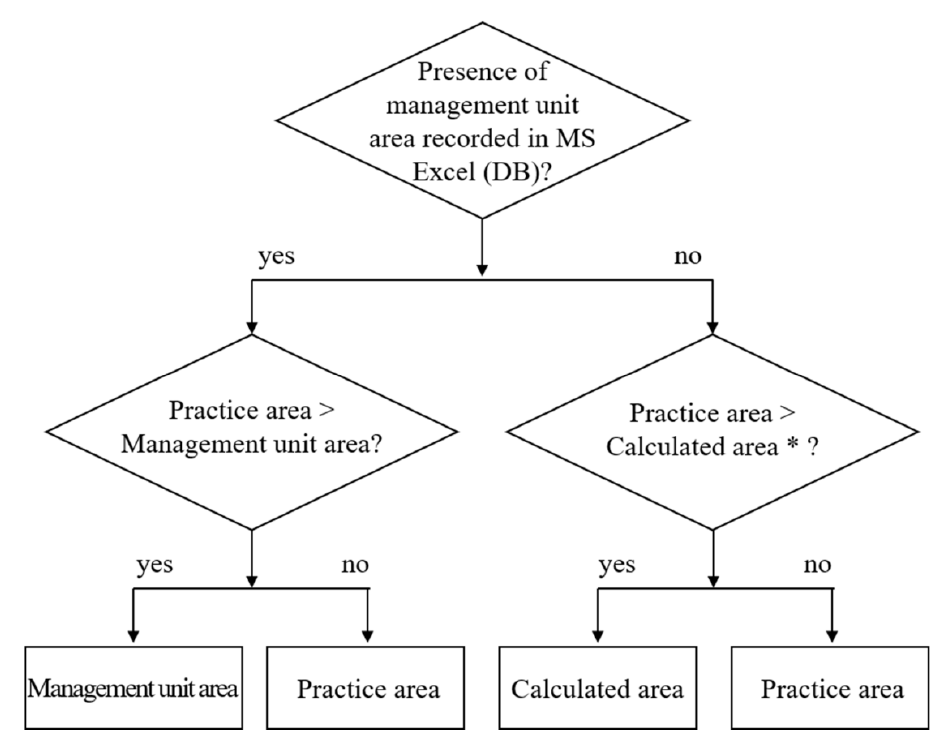
Figure 1. Decision-making process for the managed area of individual management units. * Area calculated using GIS.